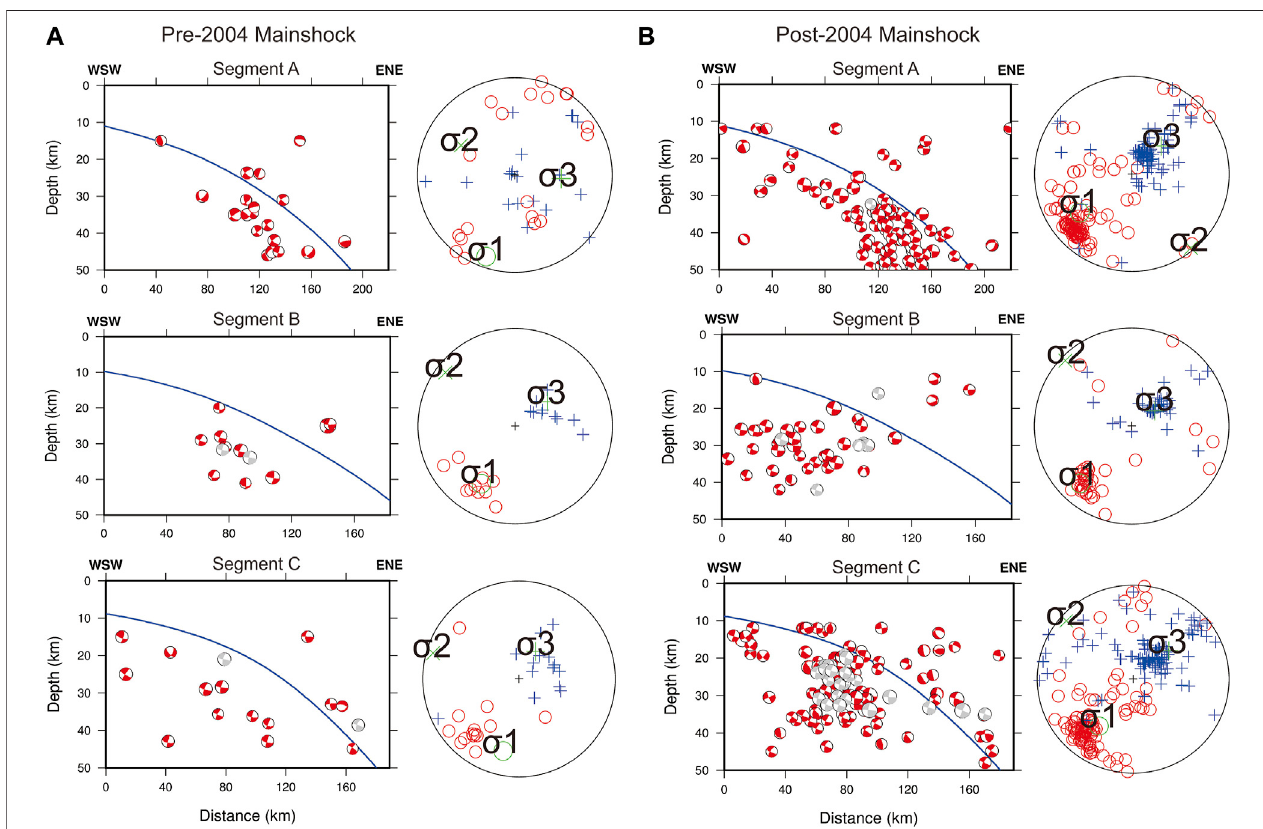
FIGURE8| Verticalcrosssectionofthedistribution offocalmechanismsineach segmentforpre- (A) and post-2004 mainshock (B) .Theobtained principal stress solutionisalsodisplayedwithP(redcircles)andT(blueplus)axesofeveryfocalmechanismontherightofcrosssectionforeachtimedomain.Theredfocalmechanisms arethedatathatacceptedinthestressinversionwhilethegrayfocalmechanismsaretherejecteddataastheyidenti fi edasmegathrustevent.Theslabusedinthecross section is obtained from SLAB2.0 (Hayes, 2018).